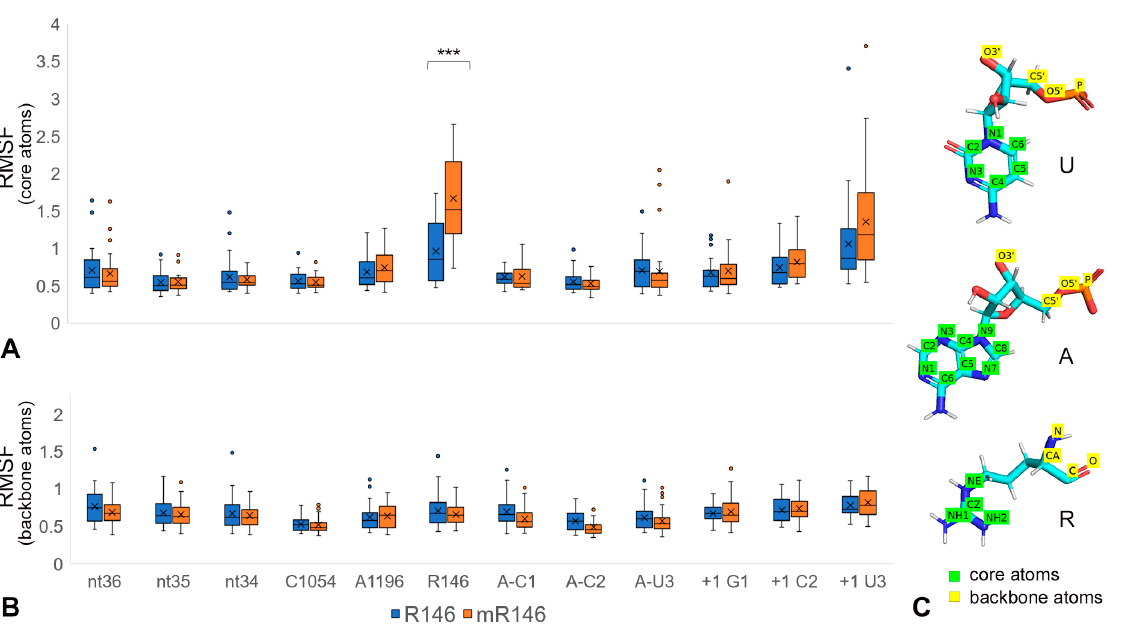
Figure 2. Methylated R146 shows elevated fluctuation. RMSF (Å) was calculated for residues comparing 30 trajectories with methylated (mR146) and unmethylated (R146) arginine. RMSF is shown for residues: CAR (C1054, A1196, (m)R146), +1 codon (+1 G1, +1 C2, +1 U3), A-site codon (A-C1, A-C2, A-U3) and tRNA anticodon (nt36, nt35, nt34). ( A ) shows RMSF calculated with “core” heavy atoms of bases (C2, C4, C5, C6, N1, N3 of C and U; C2, C4, C5, C6, C8, N1, N3, N7, N9 of A and G) and the guanidinium group (CZ, NE, NH1, NH2). mR146 has significantly greater fluctuations than R146 ( t -test p < 0.001 ***). ( B ) shows RMSF for backbone heavy atoms. No significant differences between the mR146 and R146 trajectories were observed in measurements of backbone RMSF. ( C ) Illustration of core and backbone atoms used for